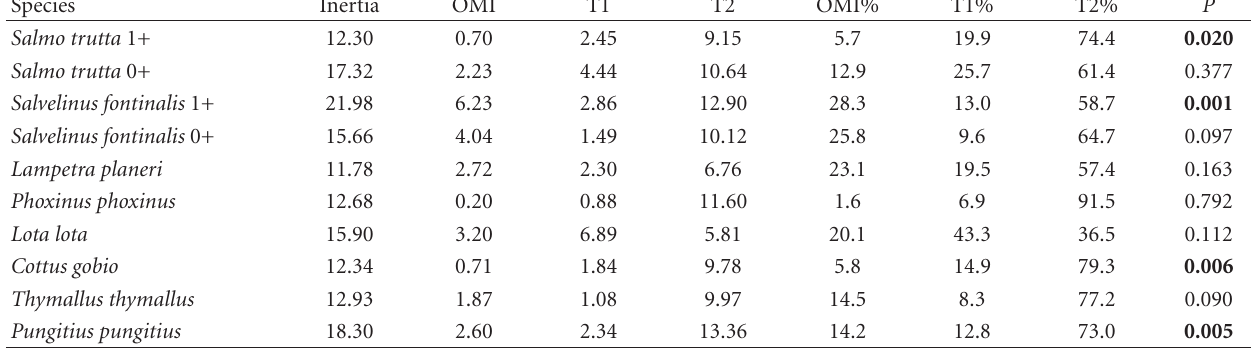
Table 4: Niche characteristics of the fish species in the 2004 surveys. For other explanations, see Table 3. Species